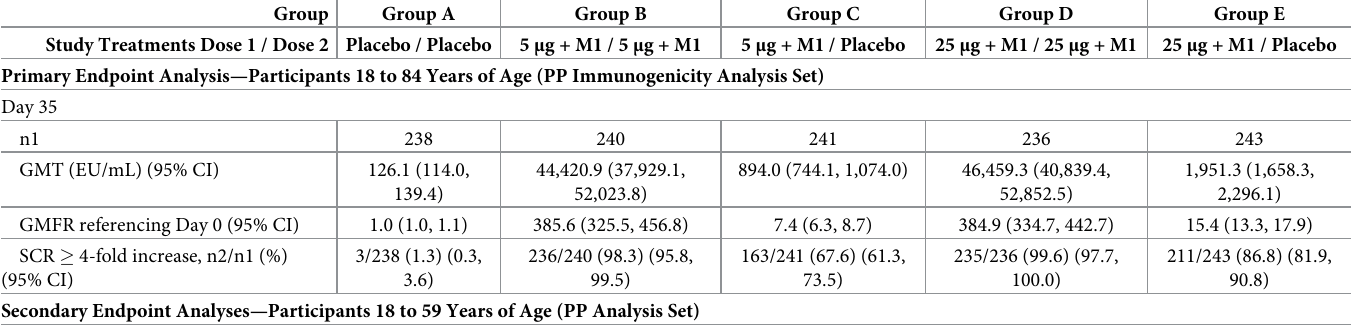
Table 2. Anti-S protein serum IgG antibody immune responses for NVX-CoV2373 study treatments by study group and age (18 to 84 years), or age subgroup (18 to 59 years and 60 to 84 years). Group Group A Group B Group C Group D Group